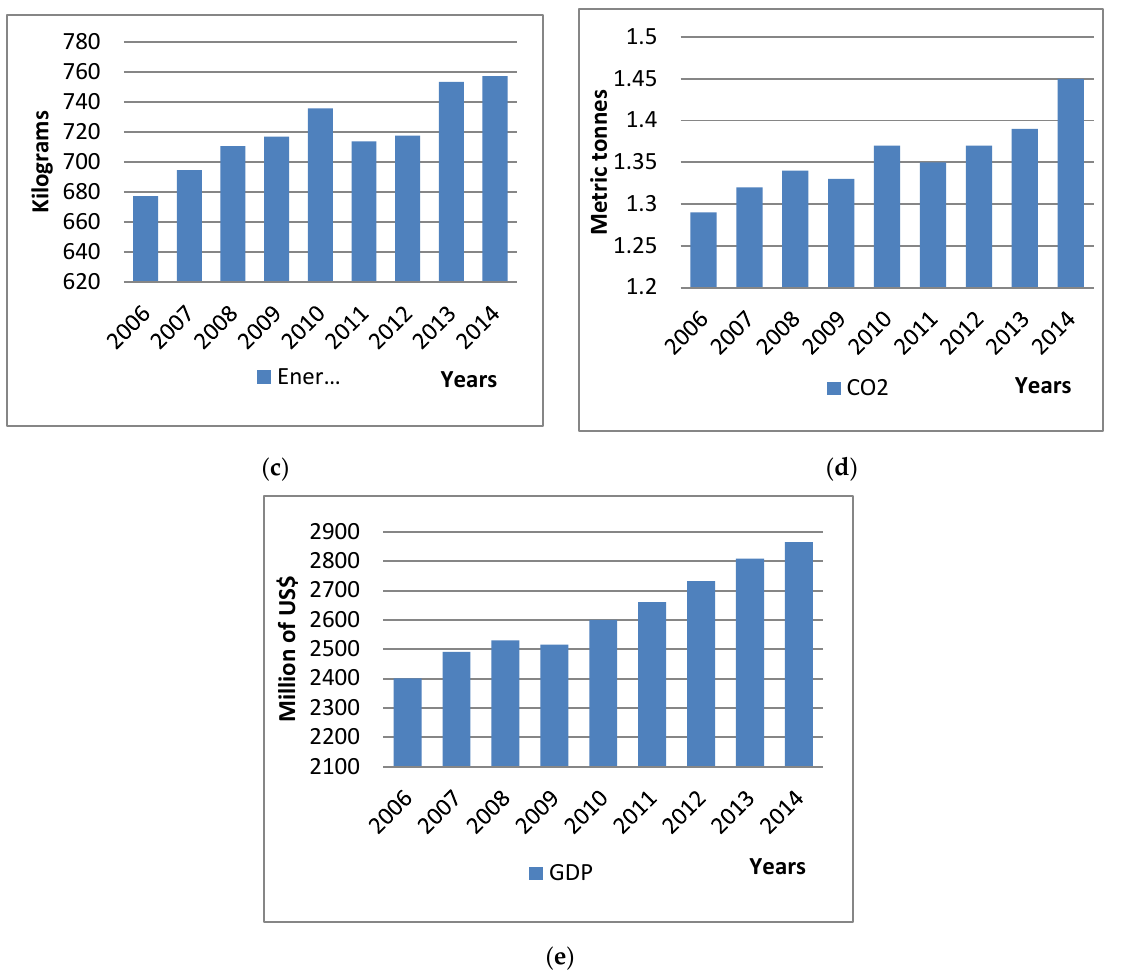
Figure 2. Mean statistical indexes of the understudy variables from 2006–2014: ( a ) capital; ( b ) labor; ( c ) energy; ( d ) CO 2 ; and ( e ) GDP.